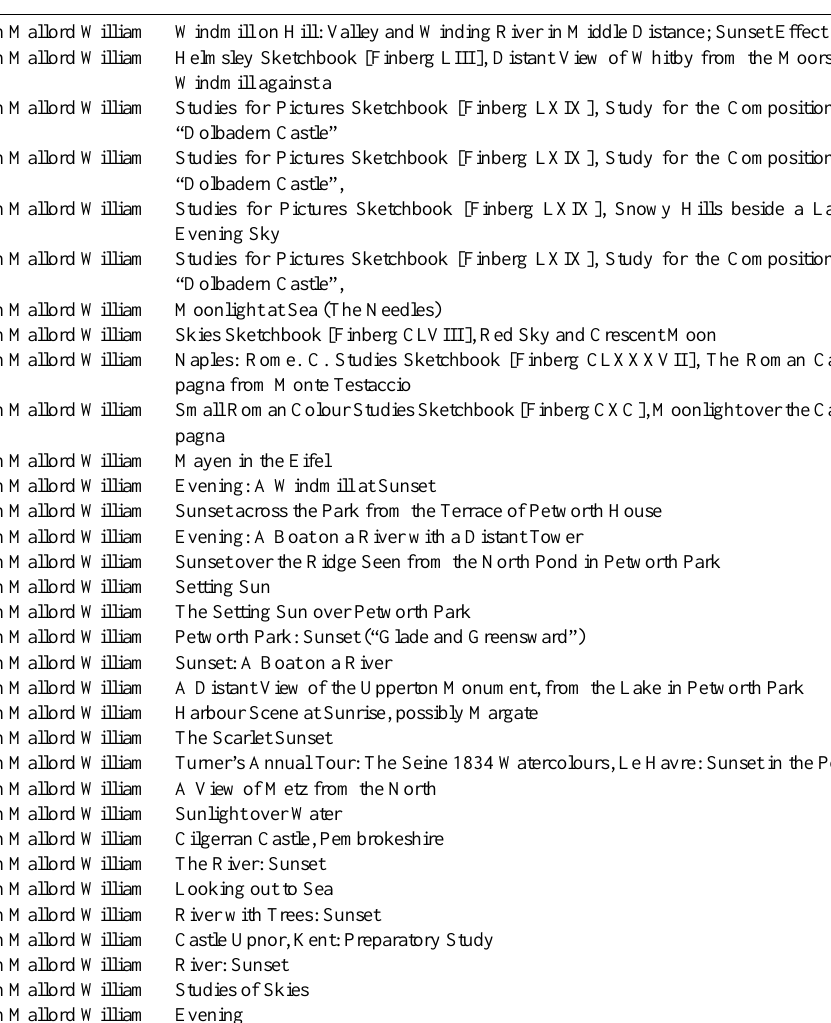
Table A1. Paintings from the Tate Gallery analysed in this work. Image